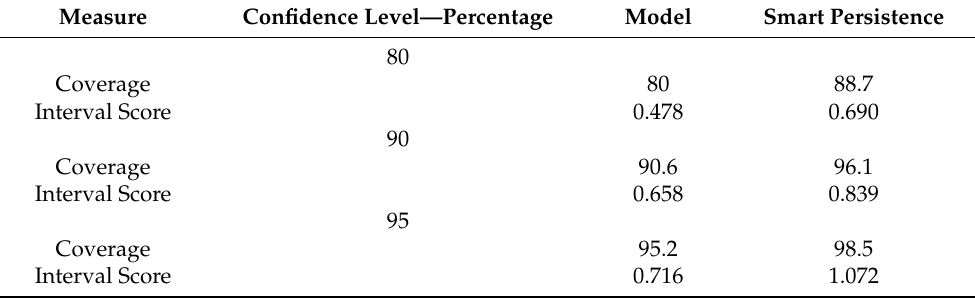
Table 2. Solar farm coverage and interval score for different confidence levels—comparison with smart